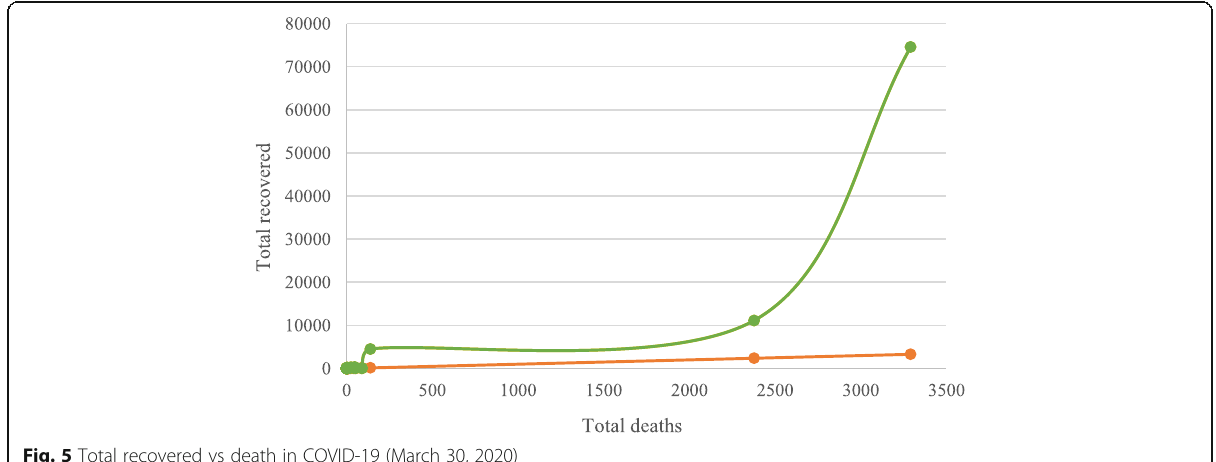
Fig. 5 Total recovered vs death in COVID-19 (March 30, 2020)